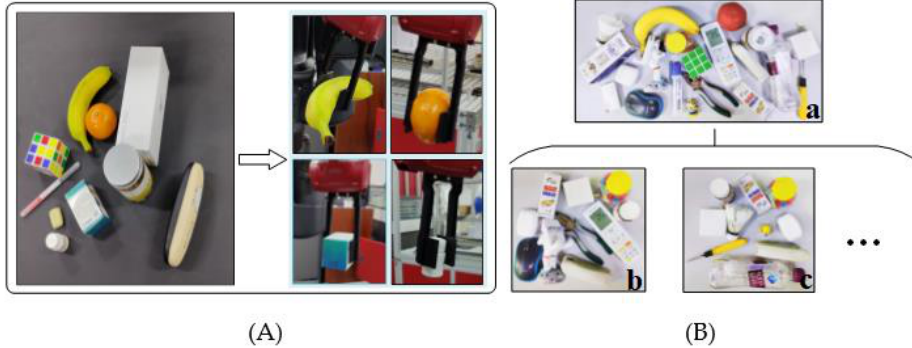
Figure 18. Grasping experiment. ( A )Single-object grasping; ( B ) Cluttered grasping scene.